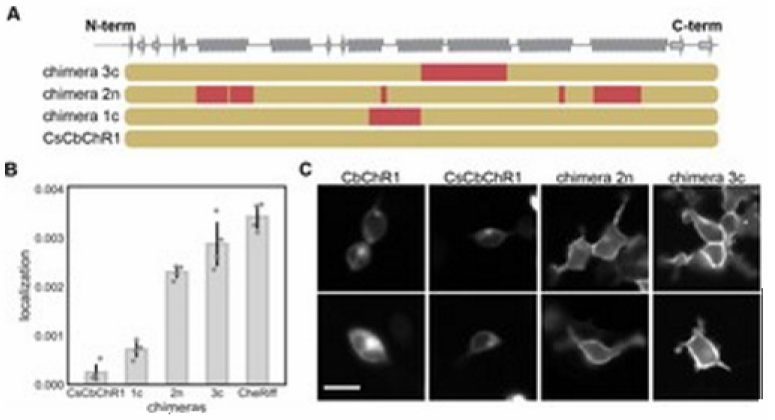
Figure 18. GP regression model that enables the engineering of the localization in CbChR1. Figure 18A presents the blocks’ identities in CsCbChR1 chimeras-each row is rep- resenting a chimera. Yellow color representation for the CbChR1 parent and red color representation for the CsChrimR parent. The Chimeras 1c, 2n, and 3c contain 4, 21, and 17 mutations, respectively with respect to the CsCbChR1. In Figure 18B, the plot repre- sents the measured CsCbChR1 localization, compared to 3 CsCbChR1 single-block-swap chimeras and CheRiff parent. In Figure 18C, 2 cell images of mKate expression in CbChR1 and CsCbChR1 compared with top-performing CsCbChR1 single-block-swap chimeras showing the differences in the ChR localization properties–the chimera 2n and the chimera 3c localize to the plasma membrane. The bar of the scale here is 20 µ